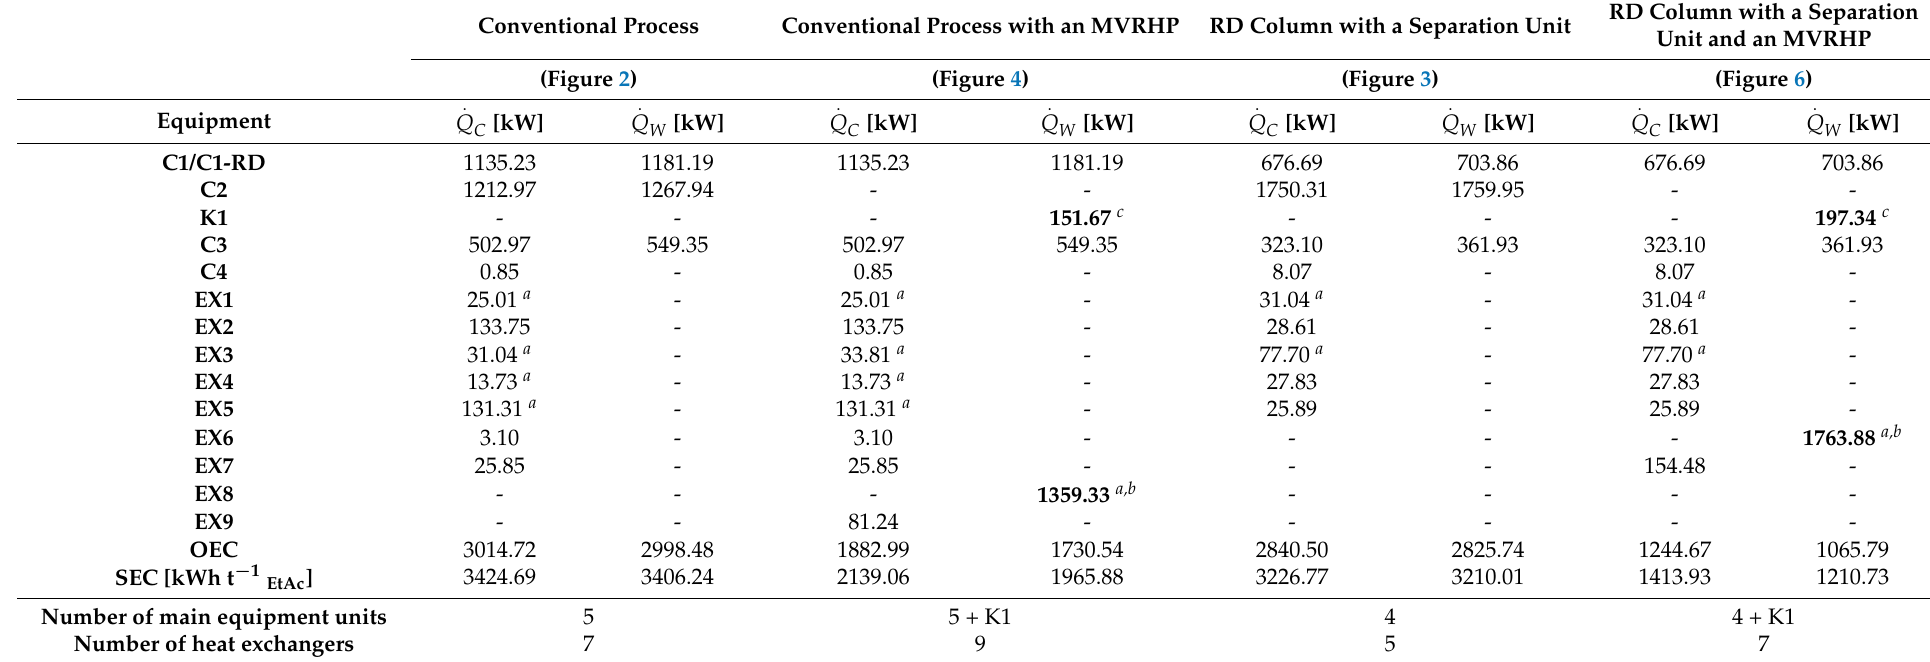
Table 3. Energy requirements and the number of equipment units for designed ethyl acetate production